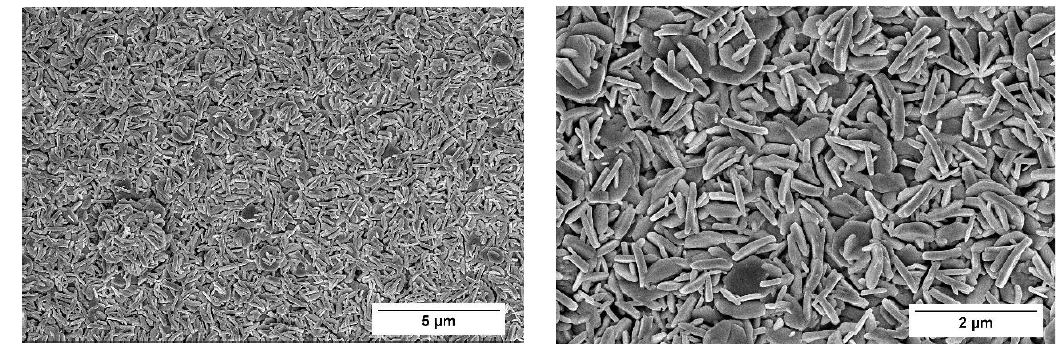
Figure 5. SEM images of WO 3 /WO 3 − x -based sample prepared from PTA + EtOH sol-gel and annealed at 500 °C for 2 h. Left side: Magnification ×10,000; Right side: Magnification ×25,000.